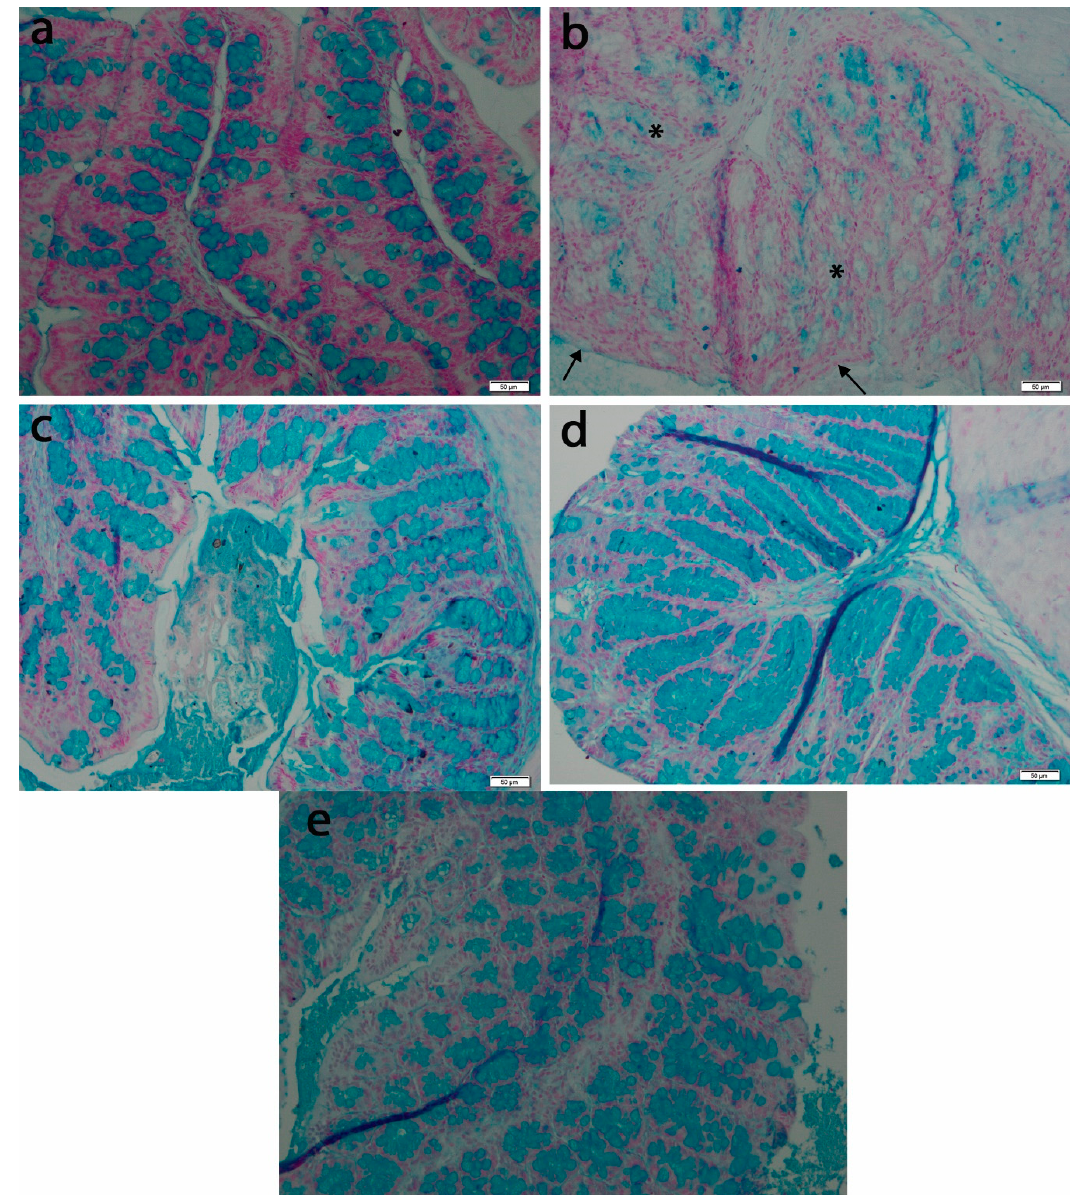
Figure 5. Appearance of goblet cells of intestinal mucosa in experimental groups: ( a ) Control; ( b ) TNBS; ( c ) TNBS + 5 mg Thuja occidentalis MT / kg of body weight; ( d ) TNBS + 25 mg Thuja occidentalis MT / kg of body weight; ( e ) TNBS + 50 mg Thuja occidentalis MT / kg of body weight. Note: discontinuous layer of mucus at the luminal face of the epithelium (arrows), and goblet cells with a more pale and inconsistent mucus (asterisks). Alcian blue staining 50×.